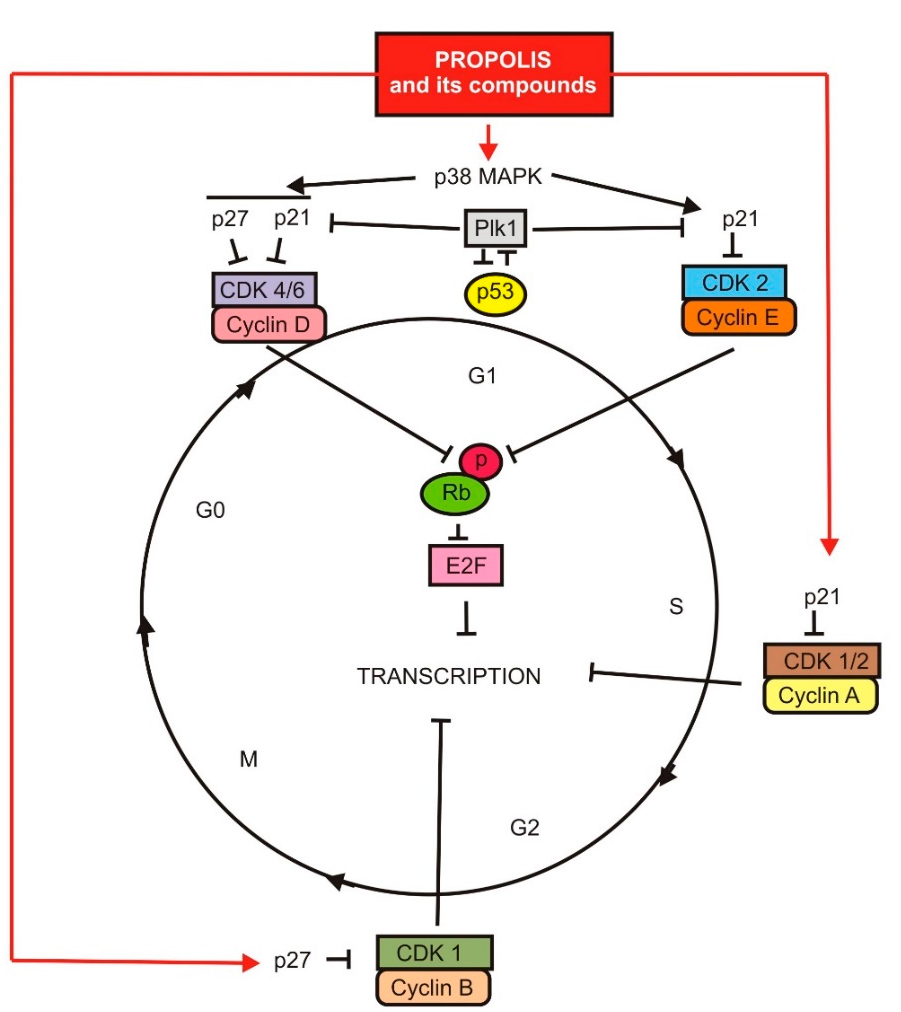
Figure 1. The influence of propolis and its components on cell proliferation.